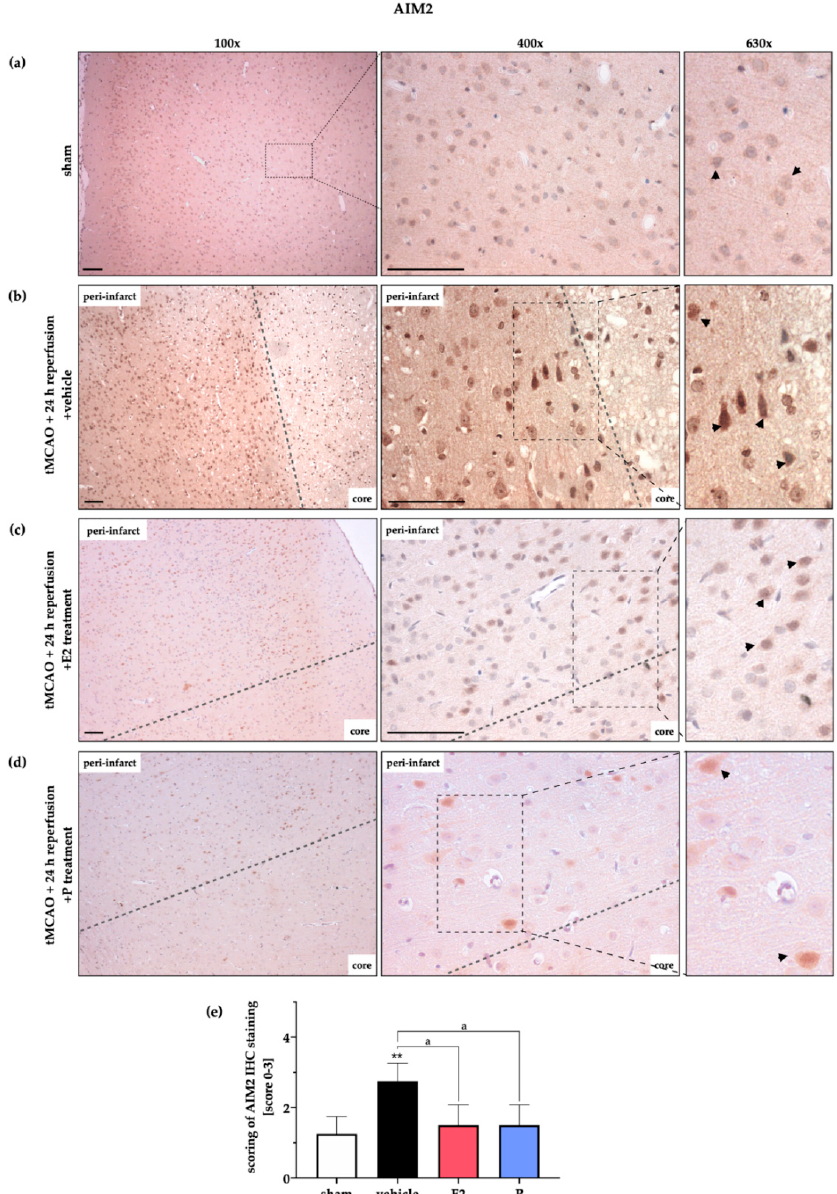
Figure 4. Evaluation of AIM2 protein expression in the peri-infarct zone after 24 h reperfusion by IHC. IHC staining of AIM2 in the peri-infarct area was utilized to strengthen WB data. ( a ) AIM2 displayed a low abundance in the cortex of the left hemisphere. ( b ) Post-ischemic brain tissue exhibited an increased AIM2 signal in cortical cells. The shape of the latter indicates that neurons most abundantly expressed AIM2 (black arrows under 630 × magnification) ( c ) E2 therapy reduced the signals of the AIM2 staining around the ischemic core (core). Overall, the staining / background ratio seemed lower in comparison to the vehicle group (arrows under 630 × magnification). ( d ) A similar reduction of AIM2 was detected after P administration. ( e ) Semi-quantitative evaluation by blinded scoring underlines the first impressions of increased AIM2 signals in the vehicle group and lower signals after E2 or P treatment. Scoring was evaluated by 1 = slight signal, 2 = medium signal, and 3 = strong signal. p -values: a ≤ 0.05; ** ≤ 0.01; asterisks indicate sham vs. the other groups; letter indicate vehicle vs. E2 or P. Data represent the means ± SEM. n = 3 (sham) or n = 4 (other groups). Black bars indicate a scale of 100 µ m. The dashed line delineates the transition zone of the peri-infarct area to the ischemic core. tMCAO–transient Middle Cerebral Artery occlusion; E2–17 β -Estradiol;